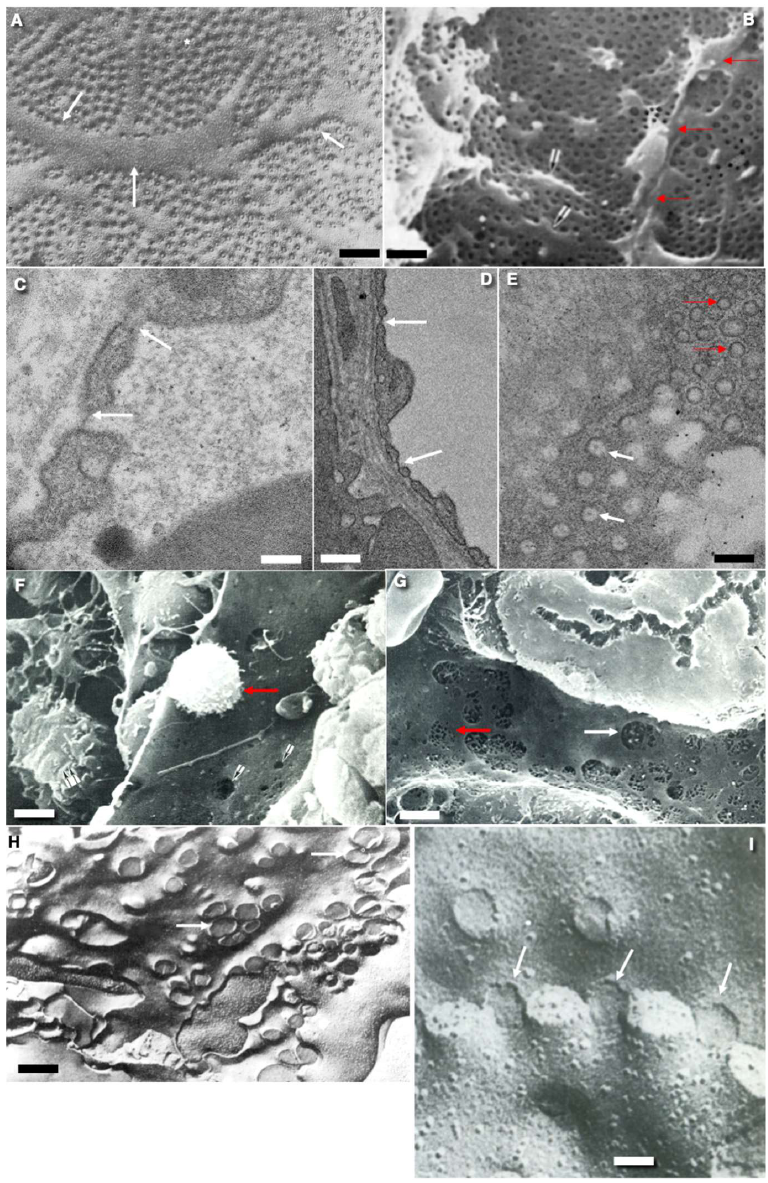
Figure 2. Structure of transcytosis compartments of rat endothelial cells. ( A ) Tangential freeze- fracture of the endothelium of blood capillary in frozen intestinal villus. White asterisks indicate the fields of fenestrae. White arrows demonstrate the thick zone of endothelial cytoplasm between the fields of fenestrae. ( B ) Scanning electron microscopy (SEM) of the surface of the thin endothelium with small pores in the glomerular blood capillary. Red arrows indicate the intercellular contact. ( C , D ) Thin fenestrated endothelium. Transmission electron microscopic (TEM) sections across the blood capillary of intestinal villus. White arrows demonstrate fenestrae. Red arrows show cross section of caveolae. ( E ) The tangential TEM section of the thin fenestrated EC. White arrows indicate